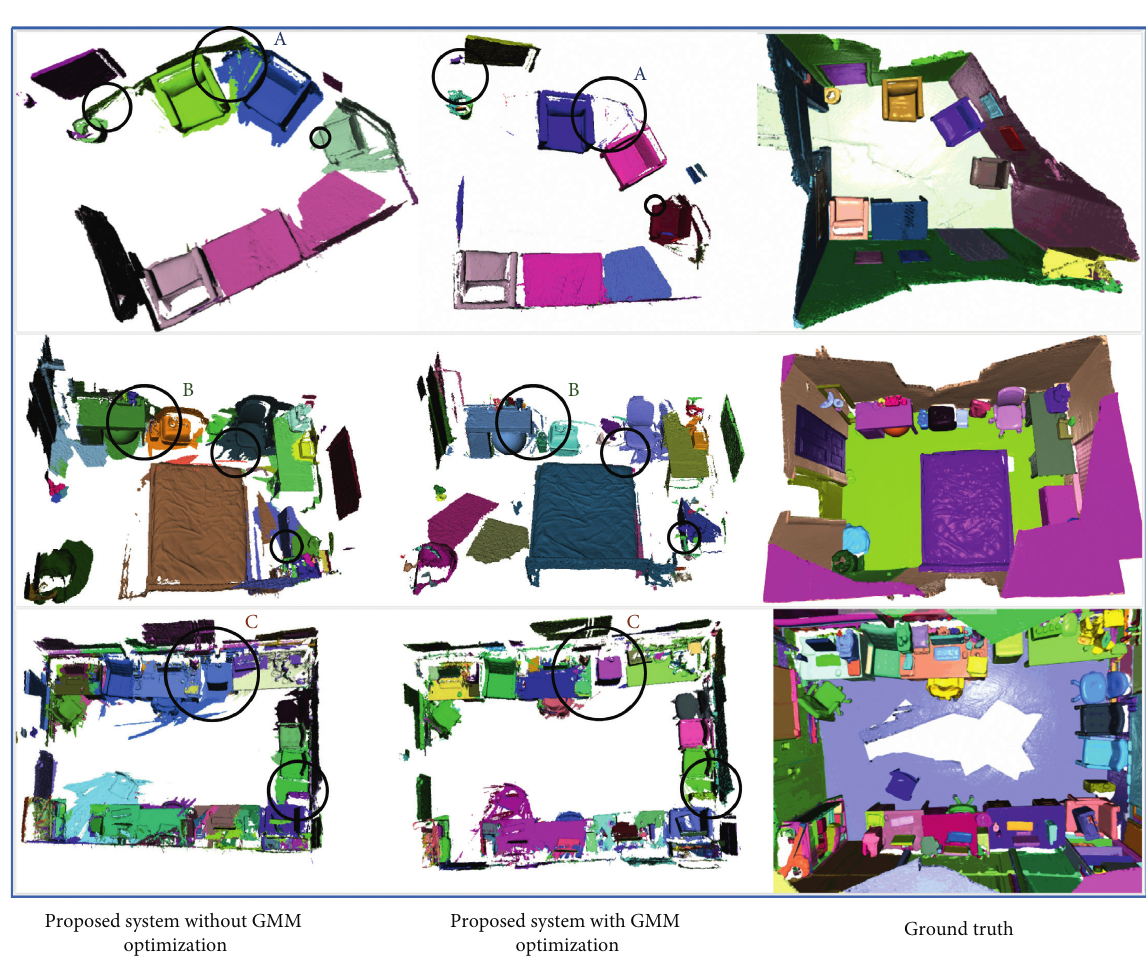
Figure 5: Ablation study on the effects of GMM optimization. The comparison shows the refinement help to improve the segmentation